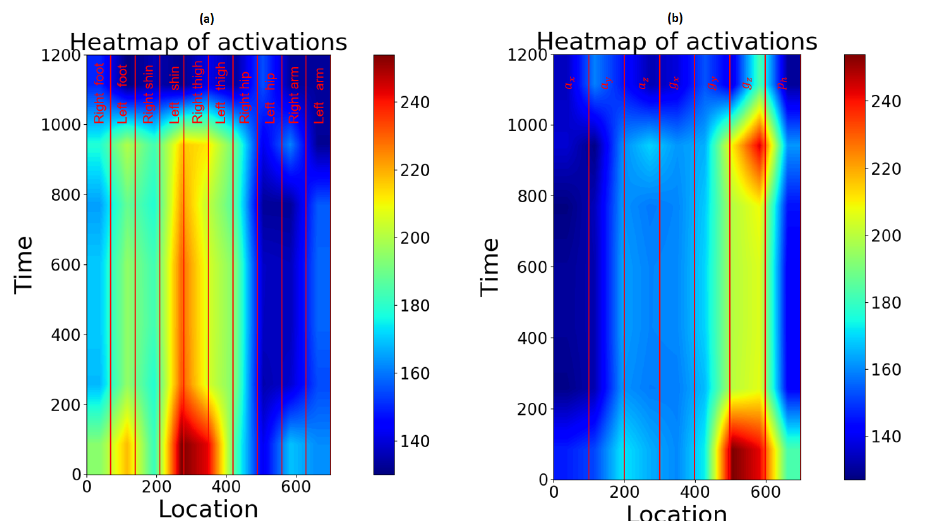
Figure 9. Activated regions in the last convolutional layer when predicting the gait phases. In ( a ) the channels are arranged device after device (IMU1, IMU2, etc.). In ( b ) the channels are grouped by the measurement type ( a x , a y , a z : acceleration; g x , g y , g z : gyro data; p1: barometric pressure data).